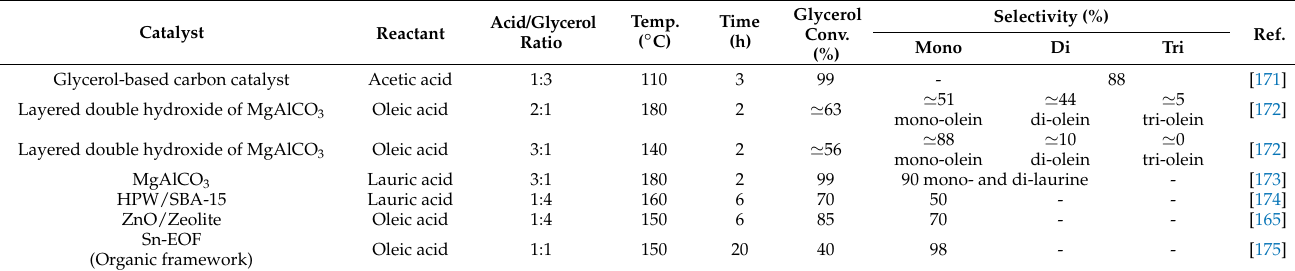
Table 6. Performance of different catalysts used in esterification of